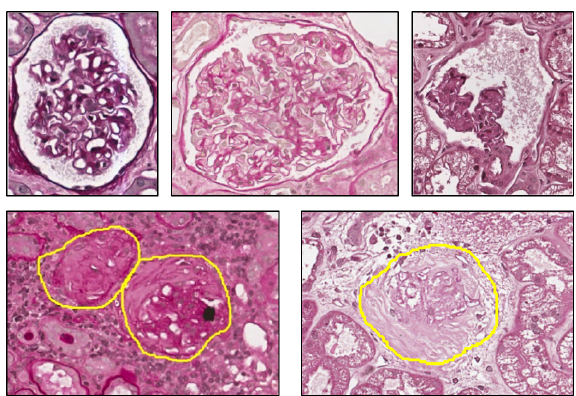
Figure 1. Glomeruli. Top row: non-sclerotic glomeruli. Bottom row: sclerotic